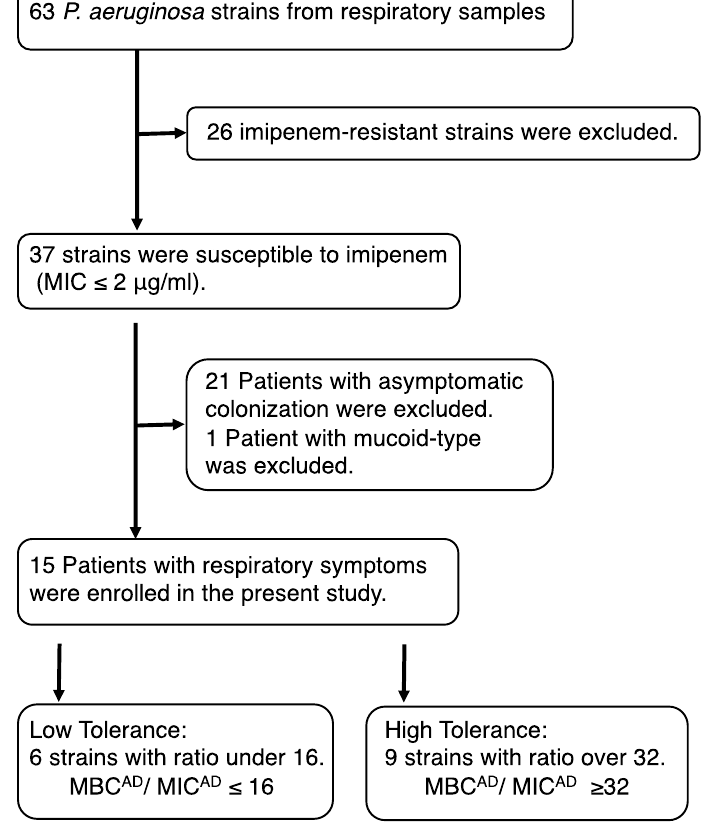
Figure 1. Flowchart of the patients included in this study. The low-tolerance and high-tolerance groups were defined (MIC, minimum inhibitory concentration; MBC, minimum bactericidal concentration; MIC AD , minimum inhibitory concentration of adherent bacteria; MBC AD , minimum bactericidal concentration of adherent bacteria).